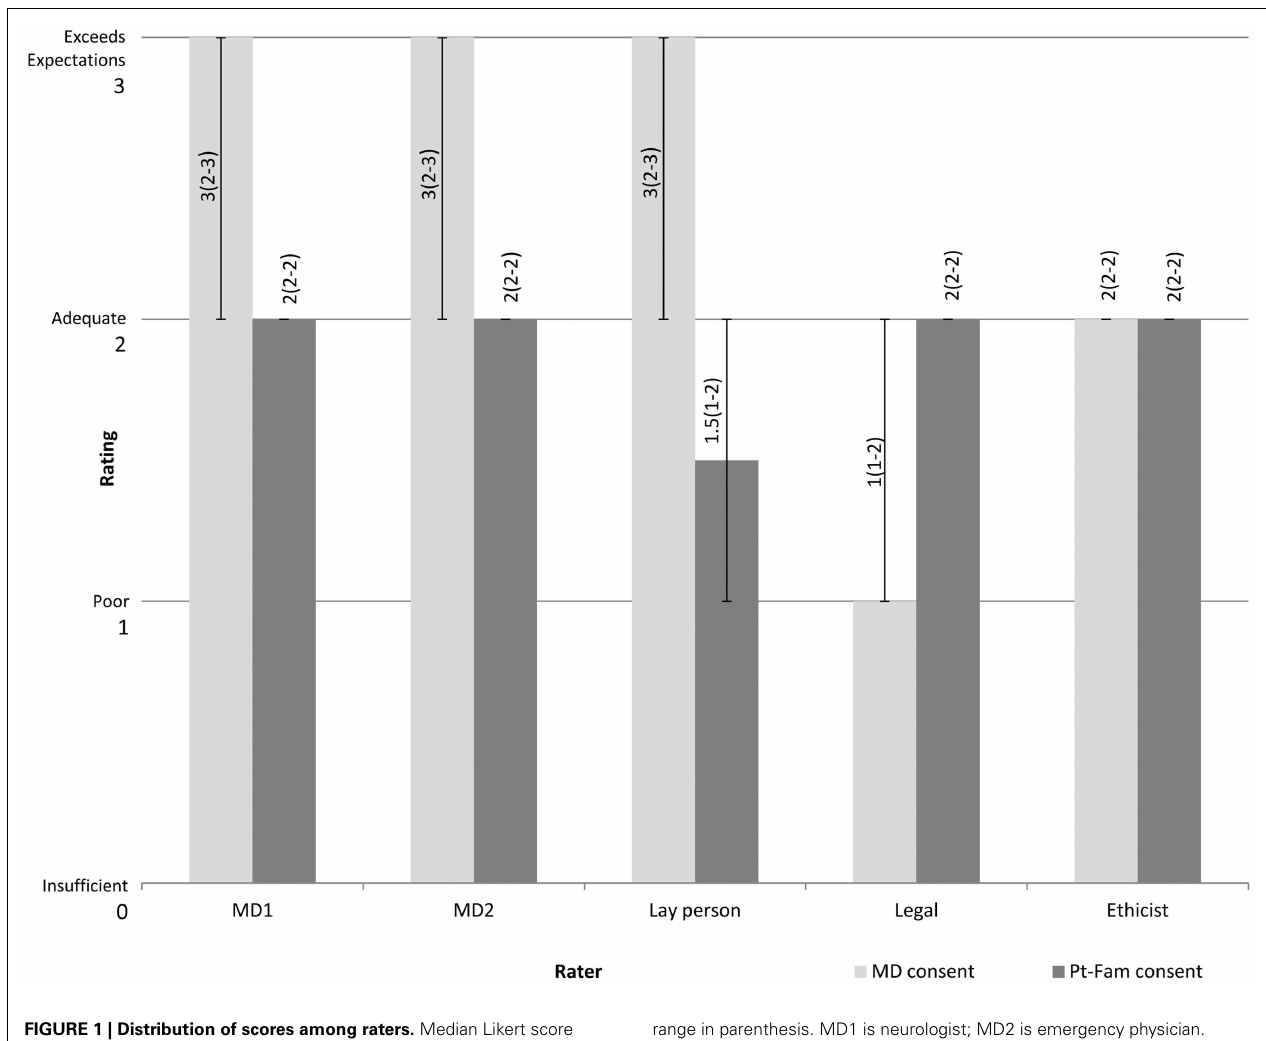
FIGURE 1 | Distribution of scores among raters. Median Likert score ratings are shown for five raters.The Likert scale rating consists of an ordinal numerical value ranging from 0 = insufficient, 1 = poor, 2 = adequate to 3 = exceeds expectations.The numbers depicted vertically along the bars show the median Likert score with interquartile